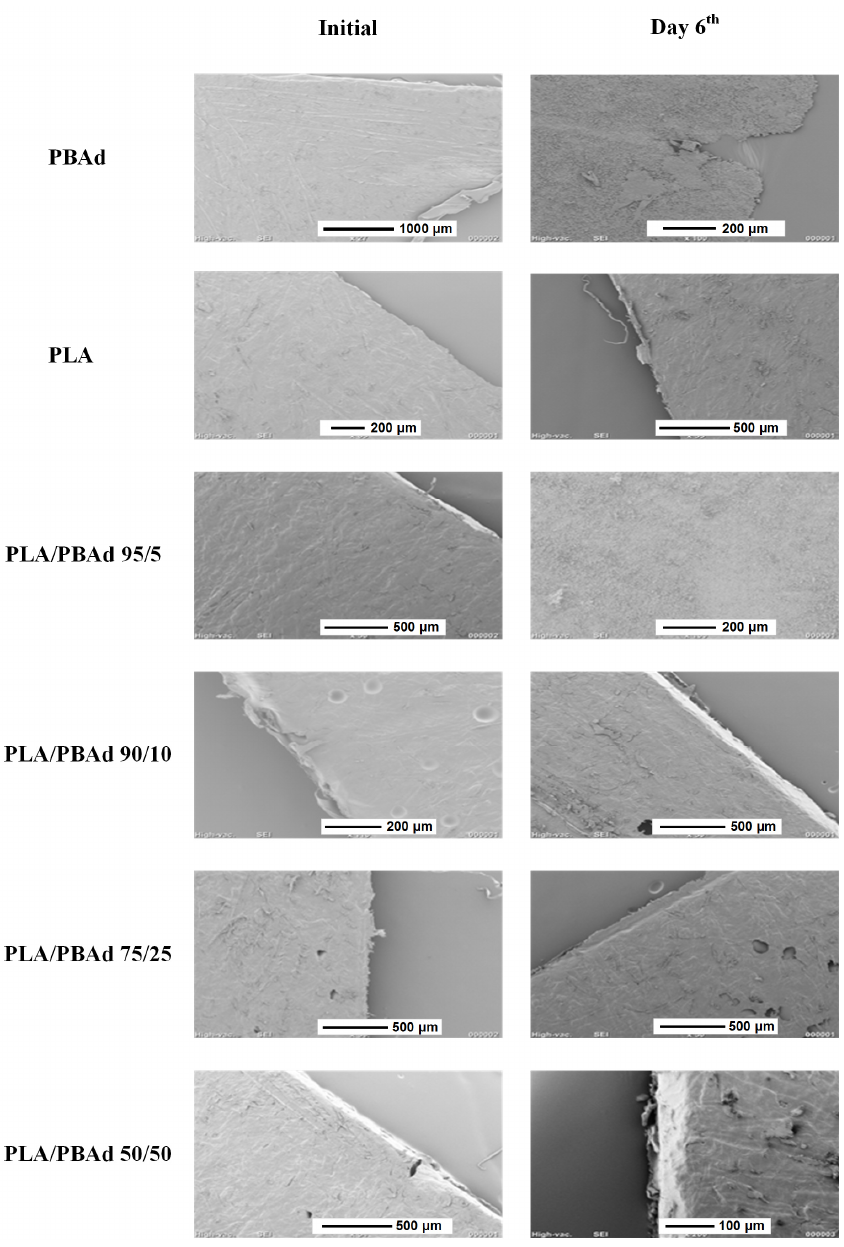
Figure 4. SEM micrographs of the neat PBAd and PLA and the various PLA/PBAd block copolymers during enzymatic hydrolysis at zero time (initial) and after six days.